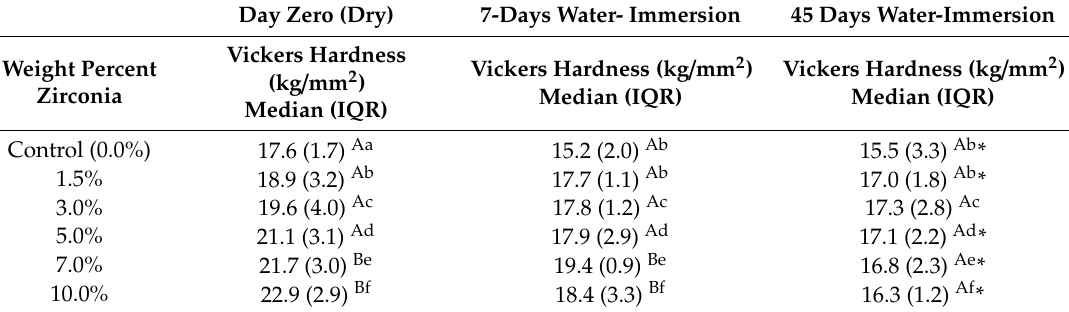
Table 3. Vickers hardness (kg / mm 2 ) (median and interquartile range) after 0, 7 and 45 days of water immersion.